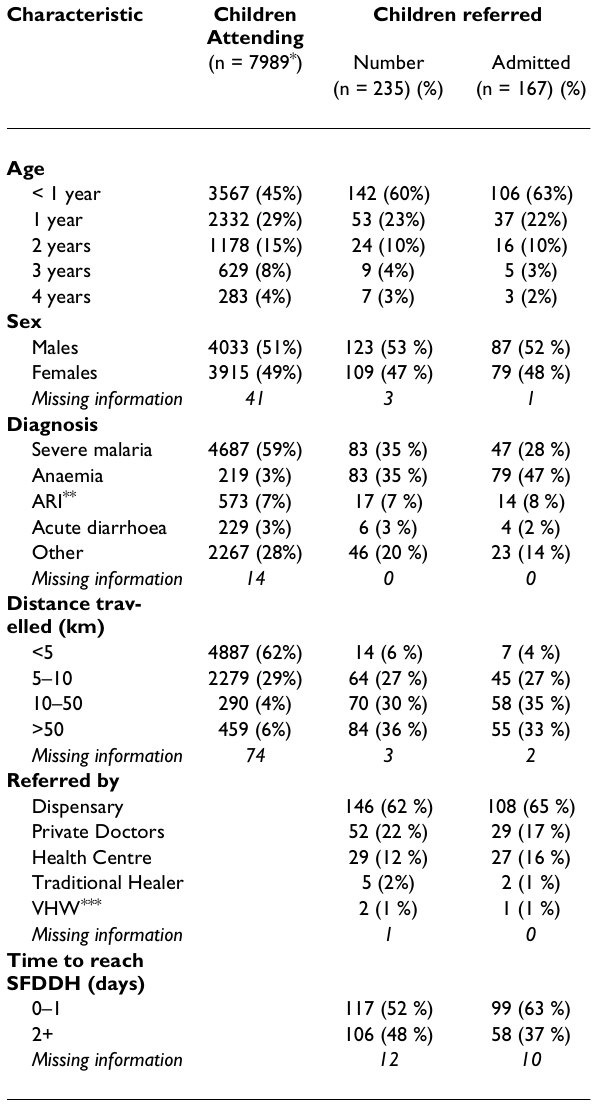
Table 1: Characteristics of sick children presenting, referred & admitted to St. Francis Hospital